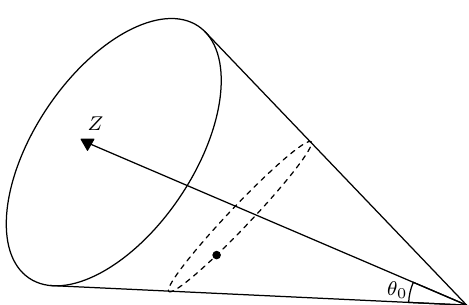
Figure 5 . The orbit of an electrically and magnetically charged object is confined to the surface of a cone with half-angle θ 0